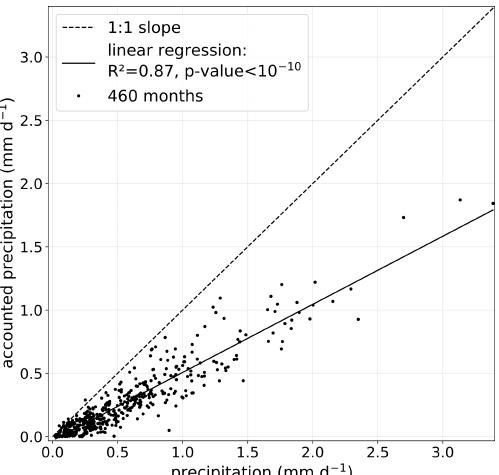
Figure 3. Scatterplot of accounted precipitation (summed-up at- tributed contributing evaporation from the Lagrangian moisture source diagnostic, mean: 0.27[0.25, 0.30]mmd − 1 ) against total precipitation in study region (mean: 0 . 56 [ 0 . 52 , 0 . 61 ] mmd − 1 ) for all months (February 1979–May 2017 using